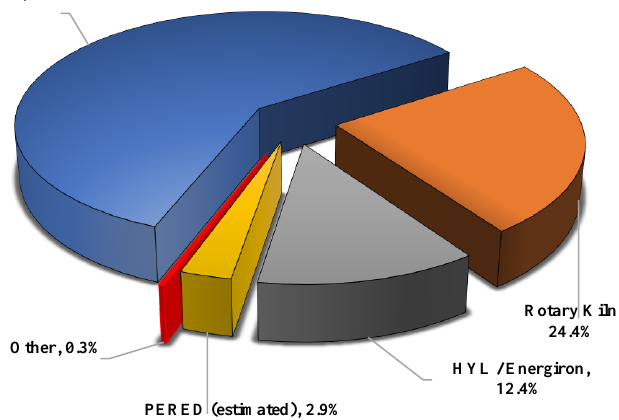
Figure 2. World DRI Production report (2020) using different technologies [7].